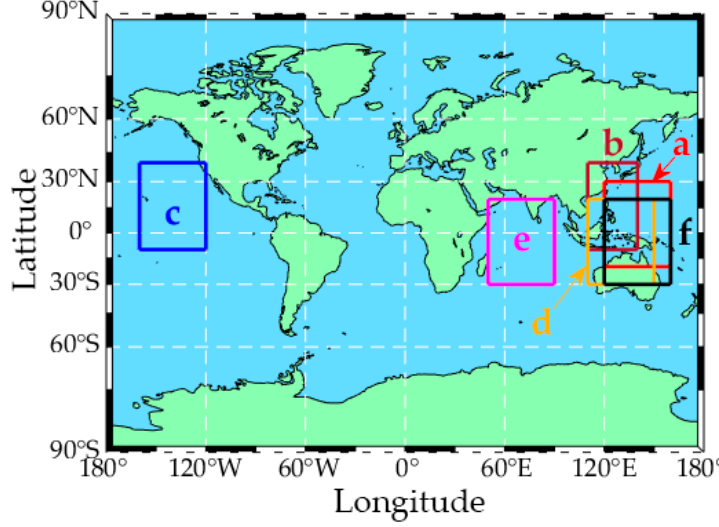
Figure 10. Test data set distribution. a region corresponding to Figure 11a (20200614 UTC: 02:00–02:30), b region corresponding to Figure 11b (20200620 UTC: 02:00–02:30), c region corresponding to Figure 11c (20200621 UTC: 02:00–02:30), d region corresponding to Figure 11d (20200710 UTC: 02:00–02:30), e region corresponding to Figure 11e (20200720 UTC: 20:00–20:30), and f region corresponding to Figure 11f (UTC:20200723 14:00–14:30).